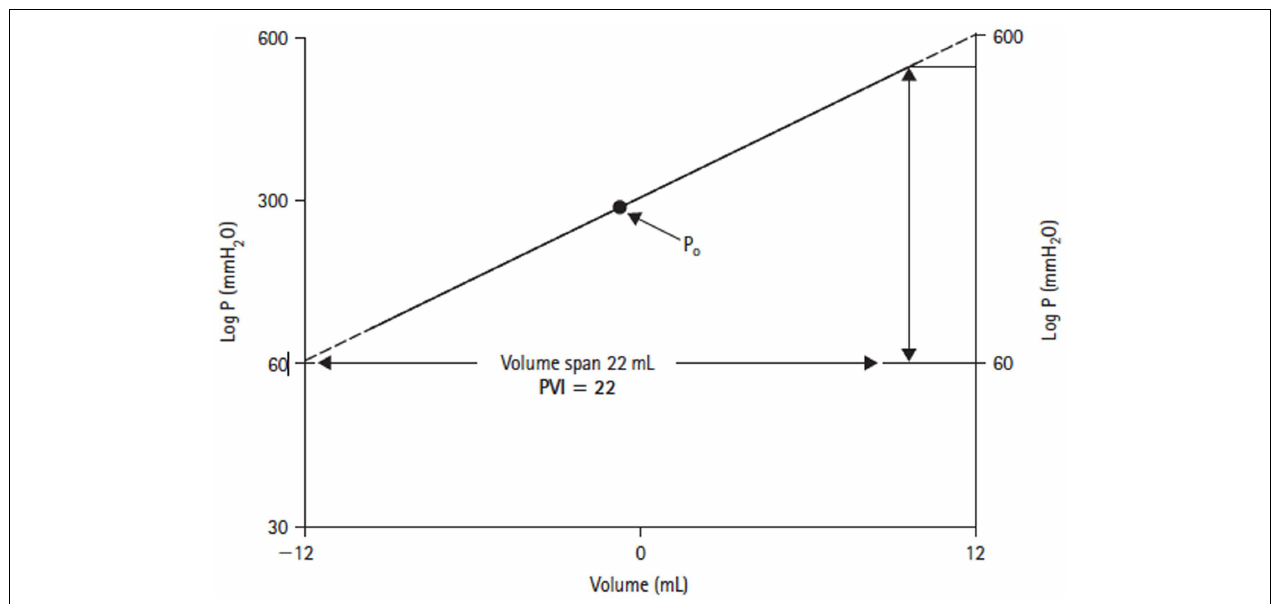
FIGURE 3 | Log ICP vs. intracranial volume relationship defined by Marmarou (14) .The pressure–volume index (PVI) is the notional volume (milliliters), which when added to the craniospinal volume causes a 10-fold rise in ICP.